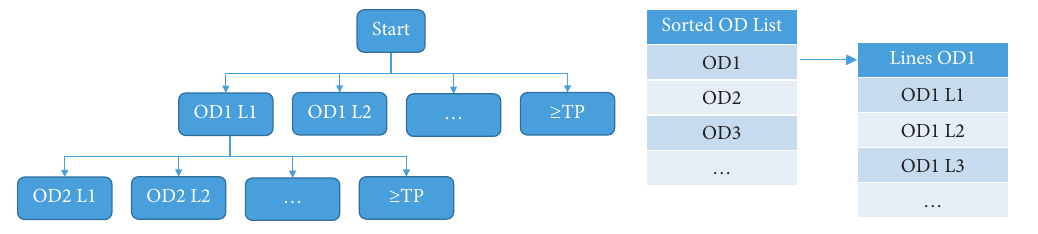
Figure 4: The branching